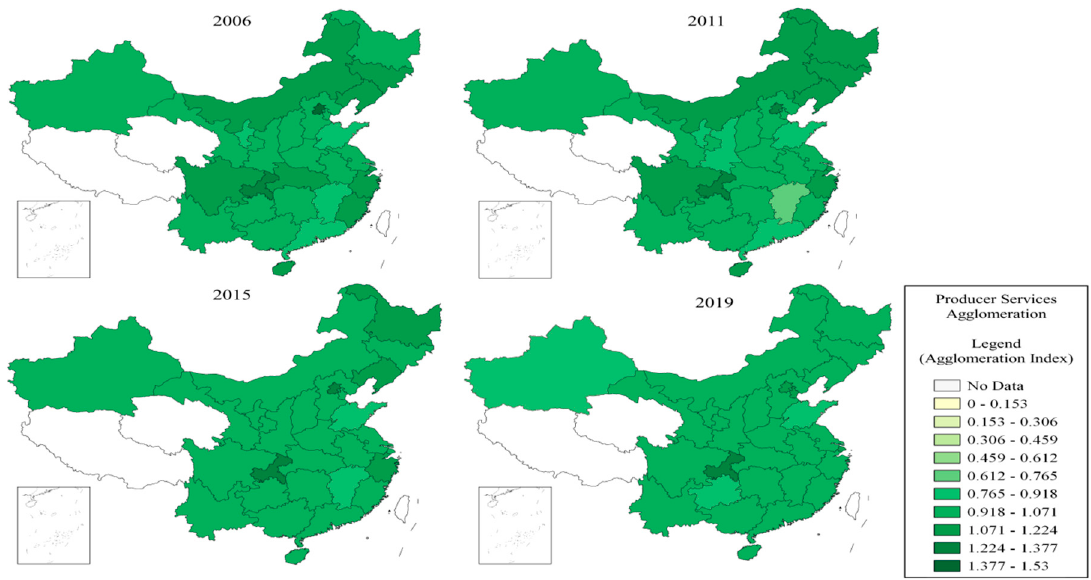
Figure 9. Distribution of producer services agglomeration in different provinces of China from 2006 to 2019